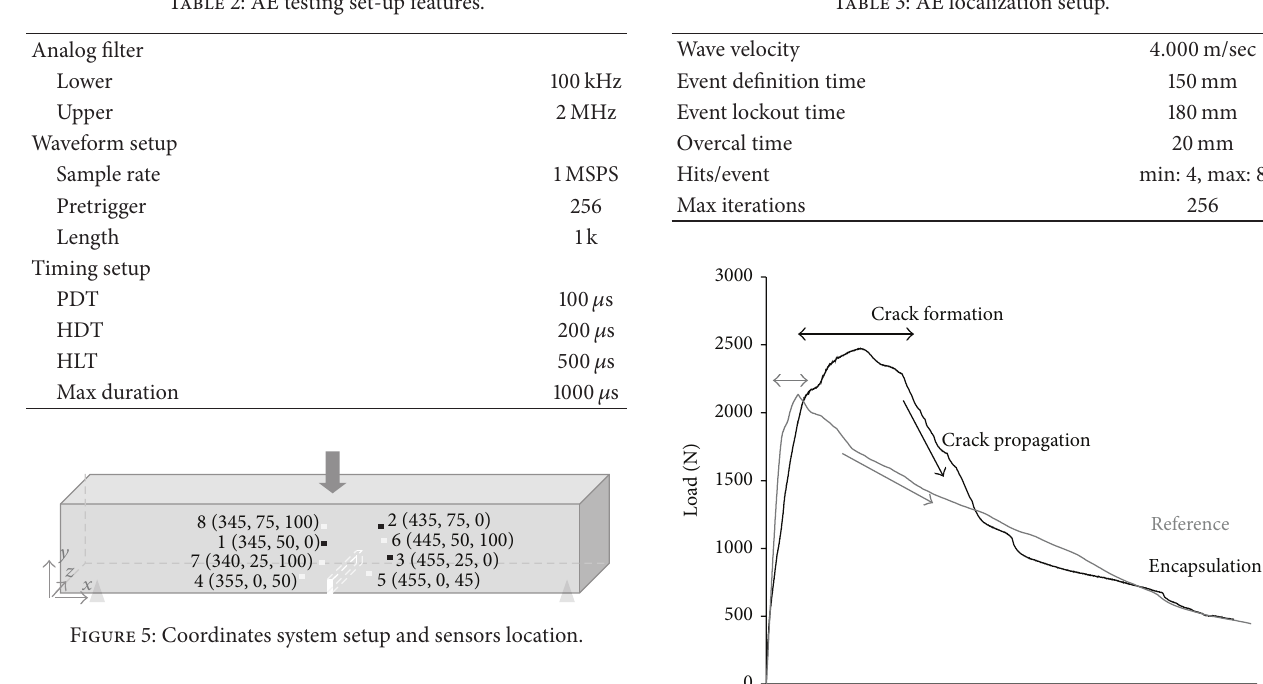
Table 2: AE testing set-up features.